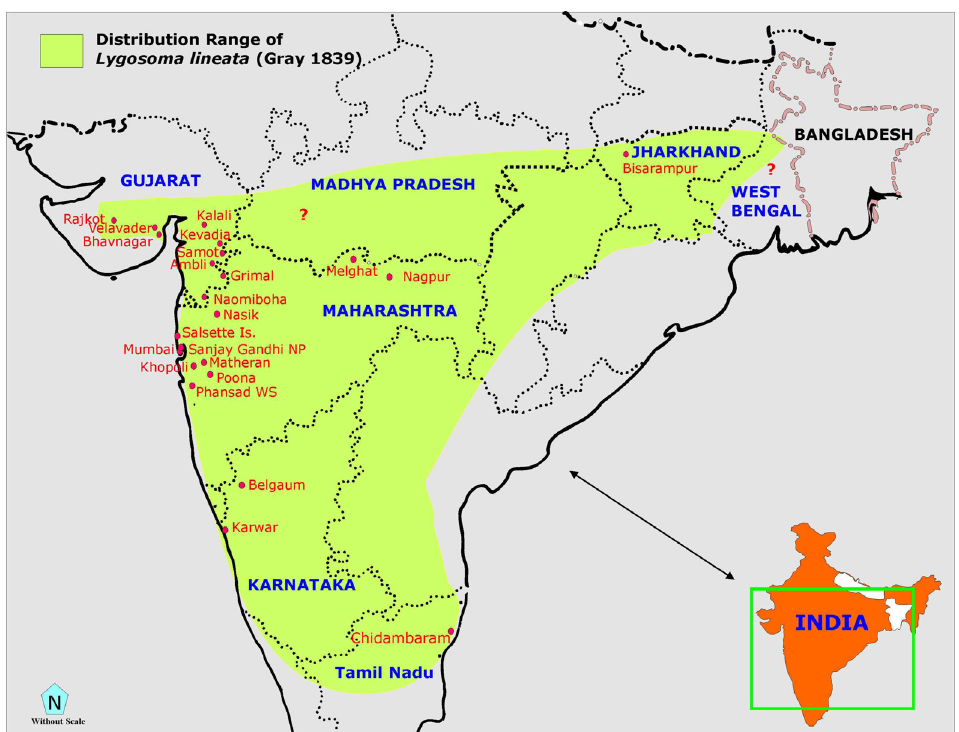
Figure 4. Collection sites and possible distribution range of Lygosoma lineata